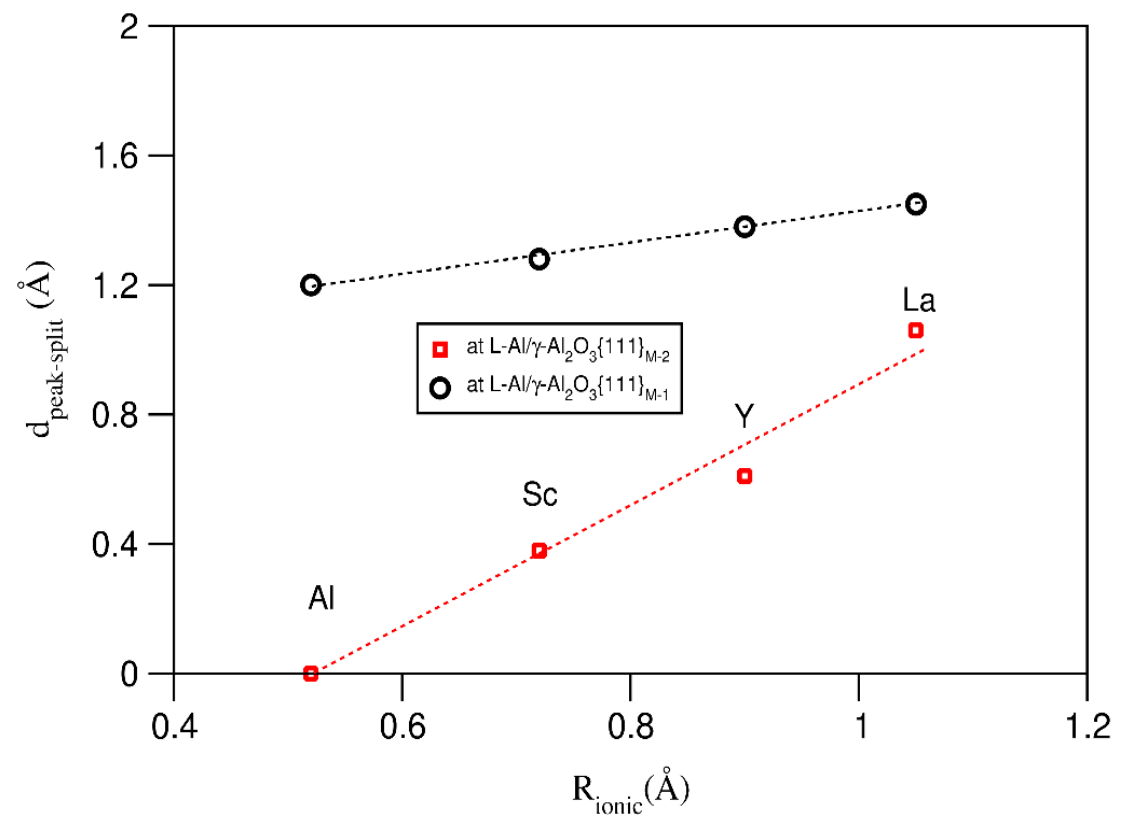
Figure 8. Linear dependences of splitting of the terminating AlM layers on the ionic radius of M 3+ in bulk M 2 O 3 (see Table 2). The slope for the Al( l )/ γ -Al 2 O 3 {1 1 1} AlM_2 interfaces is notably higher than that for γ -Al 2 O 3 {1 1 1} AlM_1 interface.